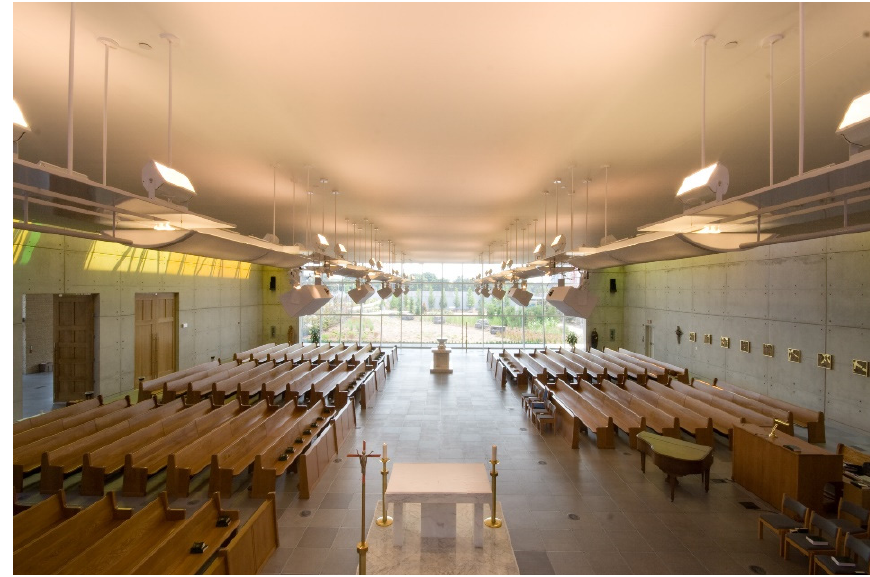
Figure 5. A view along the sacred axis towards the garden (Credit: Martin Knowles).